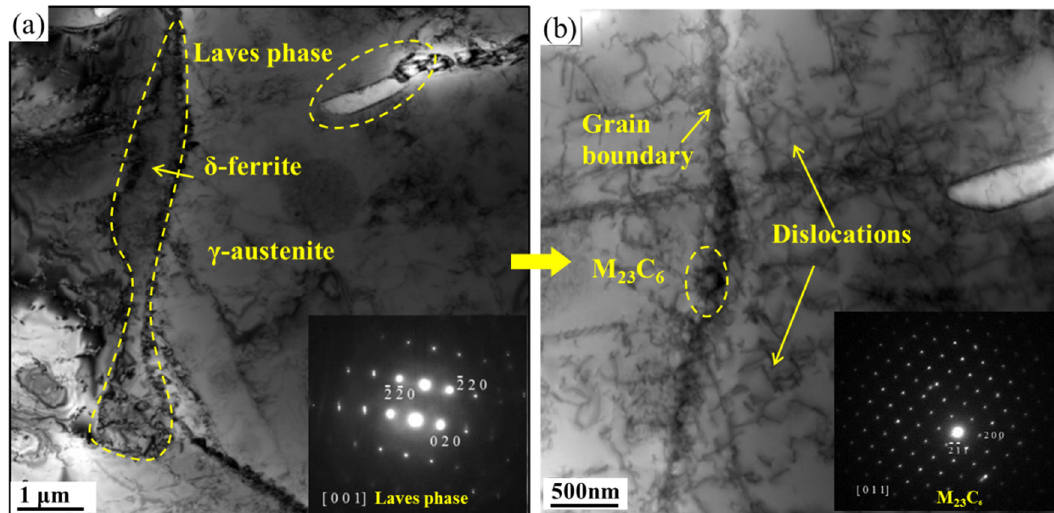
Figure 9. TEM characterization of the creep sample in WM: ( a ) δ / γ boundary ( b ) detailed boundary. The microstructures were analyzed to clarify the failure location characteristic of